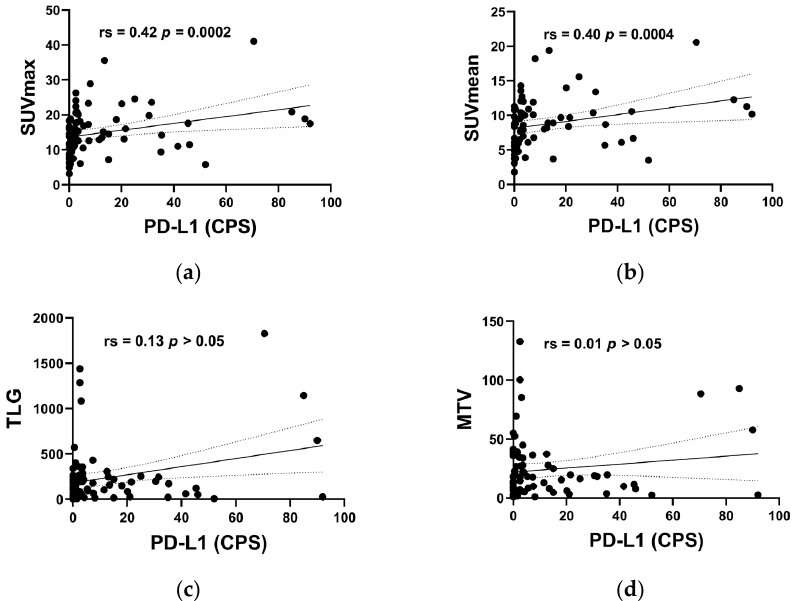
Figure 2. Spearman correlation analysis of SUVmax ( a ), SUVmean ( b ), TLG ( c ) and MTV ( d ) with PD-L1 CPS.